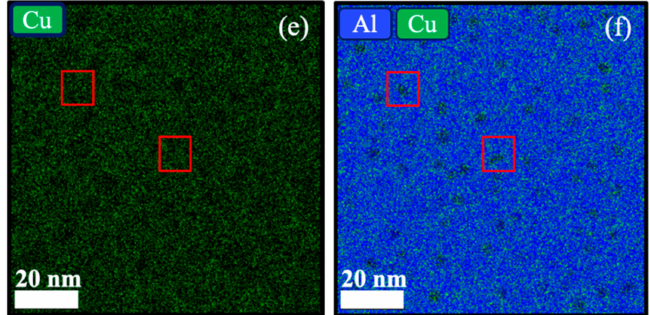
Figure 7. STEM-HAADF image with EDX mappings of η (cid:48) precipitates of 7075-LCu in the 120 ◦ C PA condition: ( a ) STEM-HAADF image; ( b – e ) EDS maps of Zn, Mg, Al, and Cu; ( f ) overlapped Al and Cu maps. η (cid:48) precipitates were indicated by the red squares.